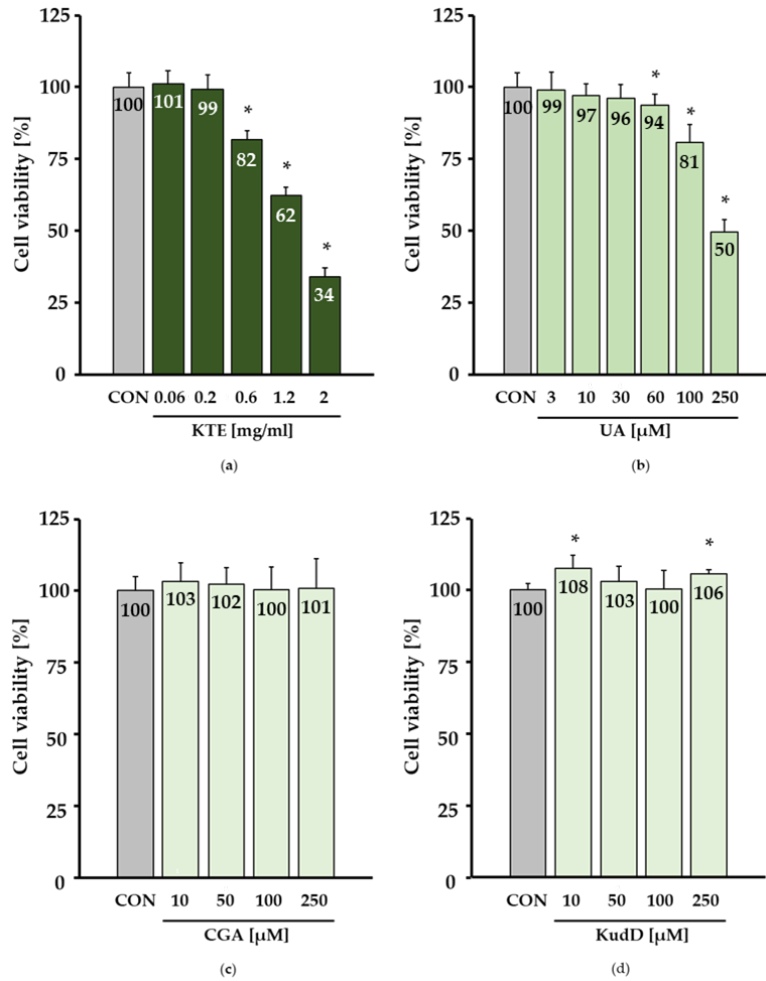
Figure 7. Dose-dependent increase in cytotoxicity due to Kuding tea extract (KTE) treatment in HepG2 hepatocytes ( a ). Ursolic acid (UA) at concentrations ≥ 100 µM exhibited moderate cytotoxicity in HepG2 cells ( b ). Cell viability remained unaffected in response to chlorogenic acid (CGA) ( c ) and kudinoside D (KudD) ( d ). Cell viability was measured via neutral red uptake assay. Cells were treated with KTE (0.06, 0.2, 0.6, 1.2, 2 mg/mL), UA (3, 10, 30, 60, 100, 250 µM), CGA (10, 50, 100, 250 µM) and KudD (10, 50, 100, 250 µM) for 24 h. All data are expressed in relation to the control group (CON, dimethyl sulfoxide). Data are given as the mean + SD. * indicates a significant difference compared with the CON group, analysed via a t-test or the Mann–Whitney U test ( p ≤ 0.05).